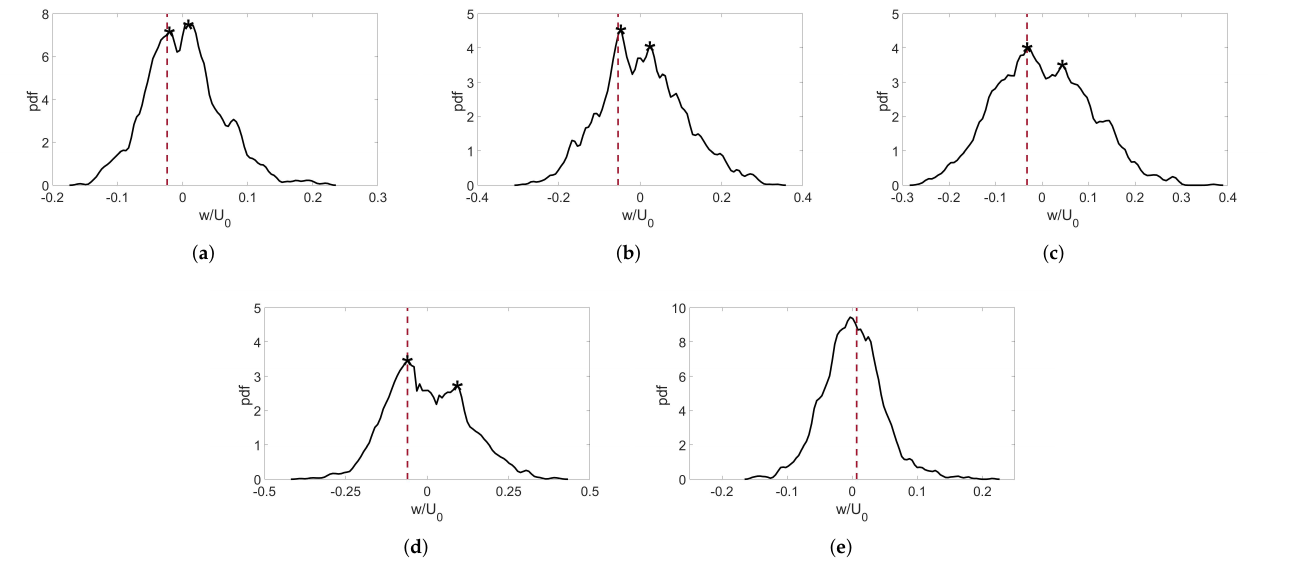
Figure 18. ( a – e ) The pdfs of the vertical velocity fluctuations just upstream of the core of JV1 (in the mean flow) within the planes identified in Figure